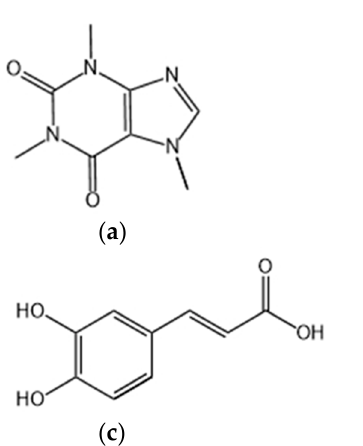
Figure 2. The chemical structure of the three coffee ingredients: ( a ) caffeine, IUPAC name: